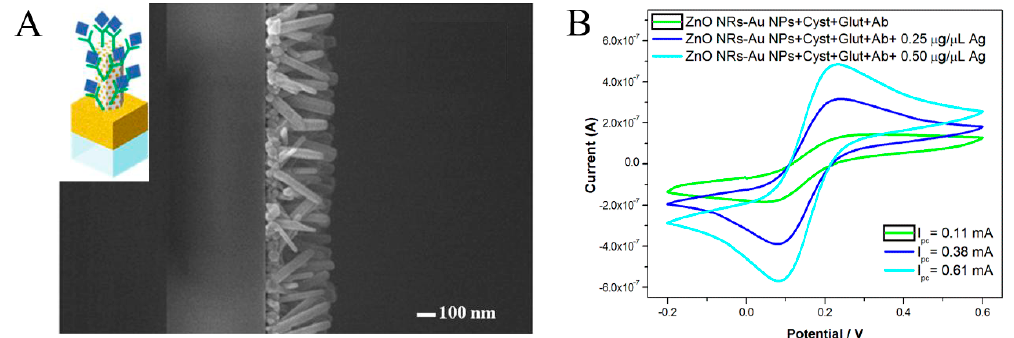
Figure 3. ( A ) SEM surface micrographs of ZnONR–AuNP nanohybrids from top view. Inset: Schematic model of a ZnONR–AuNP nanohybrid immunosensor for CA125 detection. ( B ) Cyclic voltammograms of ZnONR–AuNP-hybrid-modified electrodes immobilized with cystamine (Cyst), glutaraldehyde (Glut), Ab, and 0.25 or 0.50 µ g µ L − 1 of CA125 antigen. Reproduced from [46] with permission from Elsevier.